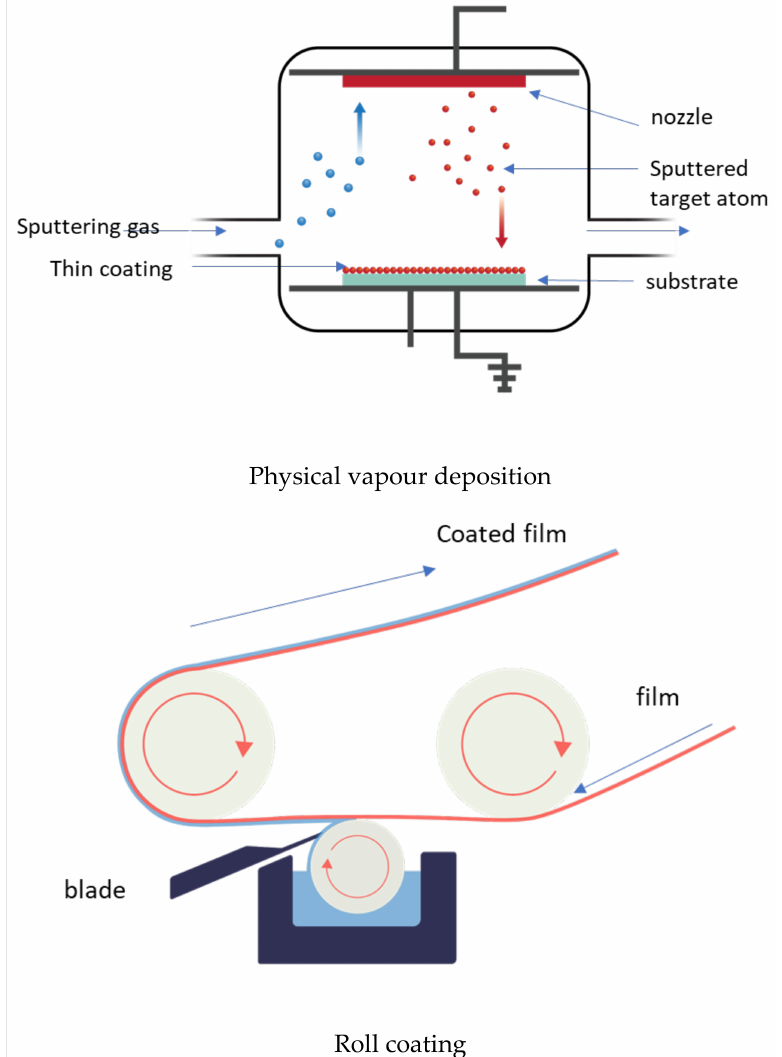
Figure 8. Some of the coating